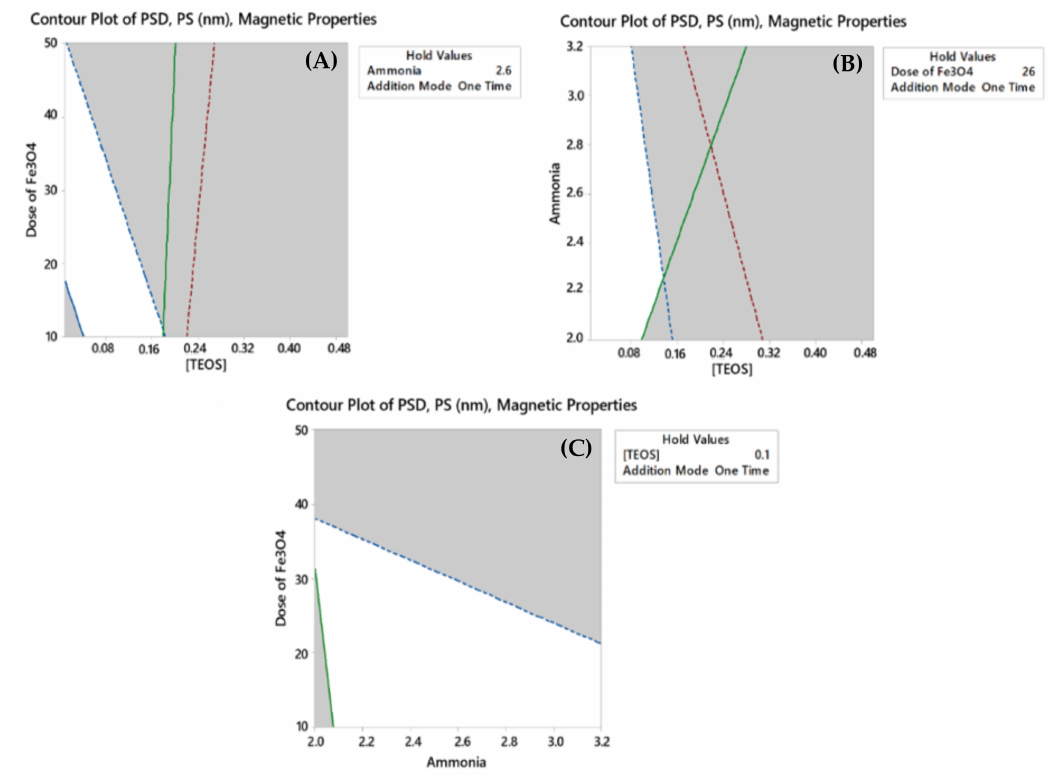
Figure 4. Overlaid contour plots of PSD, PS (nm) and magnetic properties for ( A ) Dose of Fe 3 O 4 vs [TEOS] when ammonia concentration is held constant; ( B ) Ammonia concentration vs [TEOS] when dose of Fe 3 O 4 is held constant; ( C ) Dose of Fe 3 O 4 vs ammonia concentration when [TEOS] is held constant. In all cases mode of addition was held constant. The solid boundary (green, red, or blue) represent the lower limit of the response while the dashed lines are the higher frontier of the same